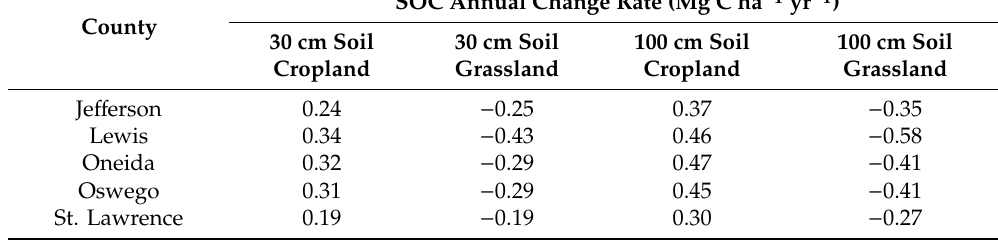
Table 3. Soil organic carbon (SOC) annual change rate (Mg C ha − 1 yr − 1 ) in four scenarios of various soil depths and land cover classes from [20,21]. The rates were applied across 22 years. Cropland includes pasture and cropland land cover in National Land Cover Data base